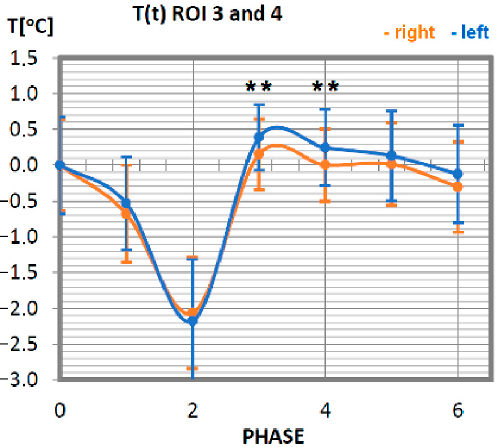
Figure 4. Temperature time (0 to 6 phase of training according to methods) changes of the biceps brachial muscle obtained before and after training using a rowing ergometer for the studied group of athletes. The statistically significant differences were marked with **, p = 0.04.